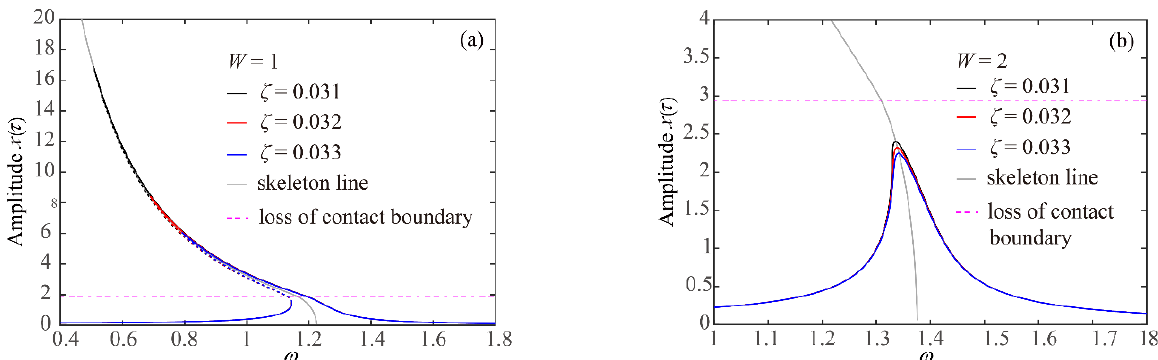
Figure 6. For α = 1.5, influence of ζ on the frequency-response peak-to-peak curves of one-sided contact system, ( a ) W = 1 and ( b ) W = 2.